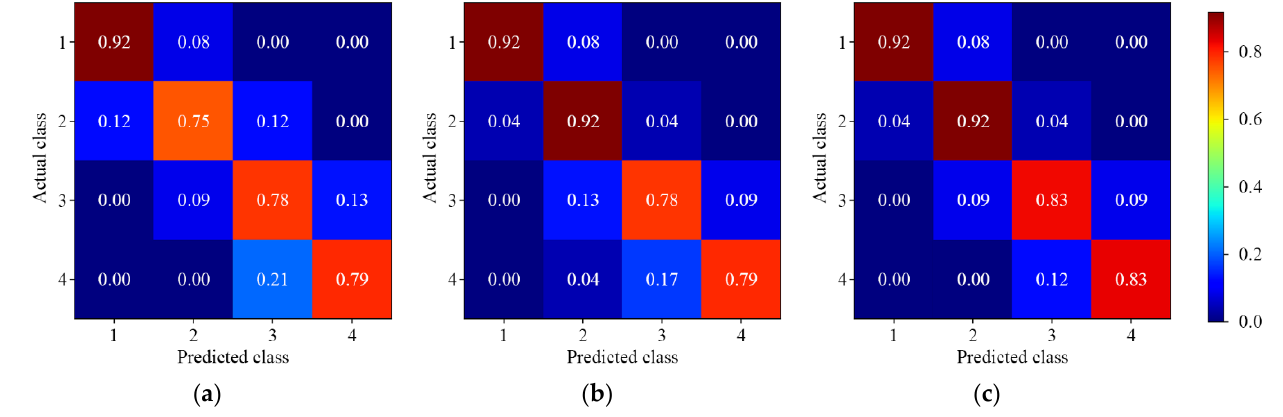
Figure 10. The normalized confusion matrix for four-level discrimination of lambda-cyhalothrin residues. ( a ) Single-depth 1D-CNN; ( b ) Symmetric multiscale 1D-CNN; ( c ) Asymmetric multiscale 1D-CNN.